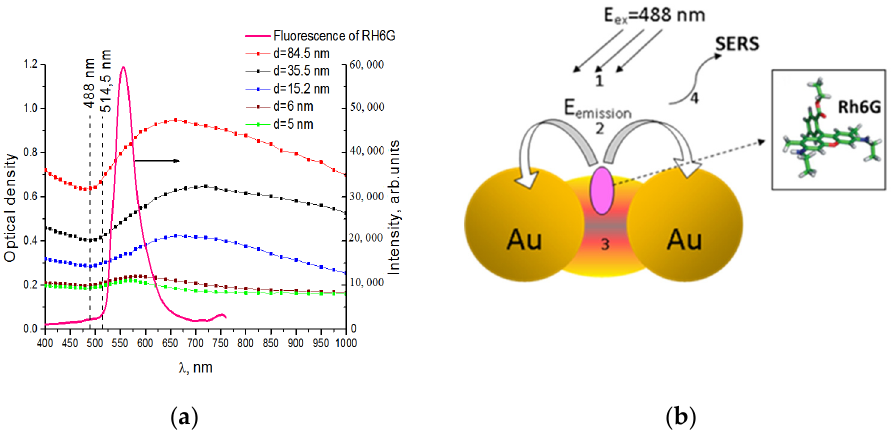
Figure 4. ( a ) Optical spectra of nanoporous Au arrays measured ondifferent thicknesses d along substrate and fluorescence spectrum of Rh6G. ( b ) Schematic representation of the SERS mechanism in the nanogap between gold nanoparticles at the excitation wavelength of 488 nm. As a result of excitation of Rh6G molecules (1), fluorescence (2) arises in the region of 560 nm, which overlaps with the region of excitation of LSPR in Au NPs (Figure 4a); therefore, the emission of dye molecules can generate plasmon resonance. As a result, an intense electric field is localized in the nanogap between